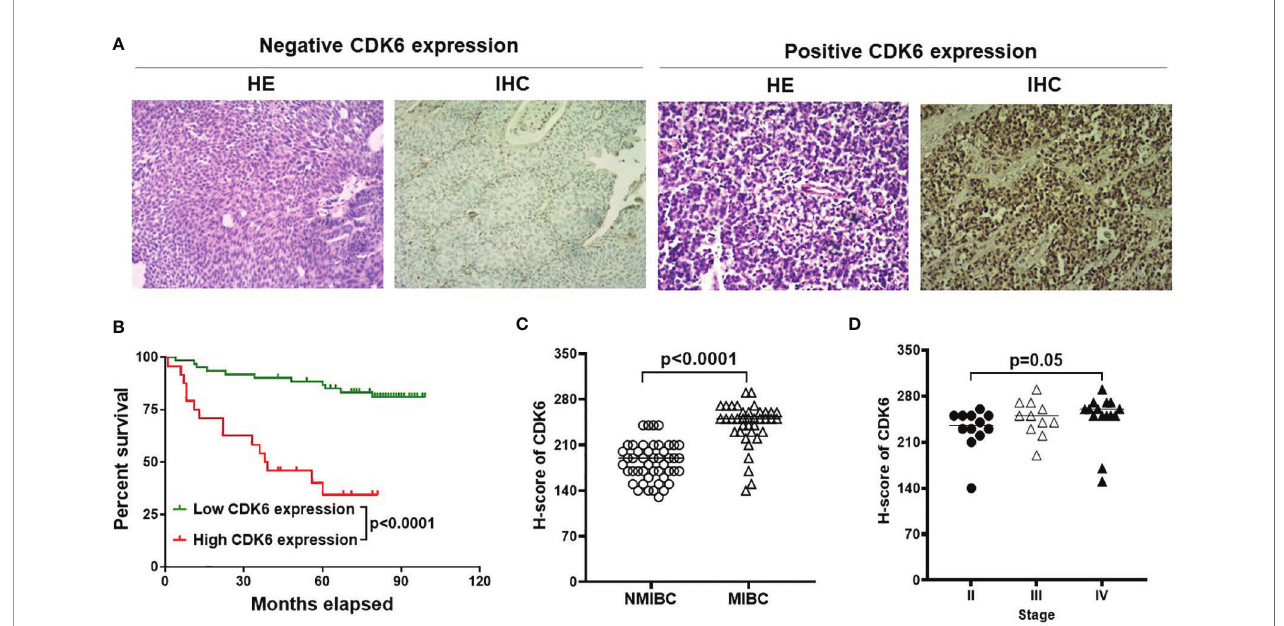
FIGURE 2 | IHC for CDK6 expression in BLCA. Representative images of H&E and IHC staining from negative and diffusely strong positive cases [ (A) , Magni fi cation, X40]. Cases with high H-score was correlated with worse prognosis compared with low or no expression group [ p < 0.0001, (B) ]. Furthermore, MIBC group (n=38) displayed higher CDK6 expression compared to NMIBC group (n=47) [ p < 0.0001, (C) ], but there was no difference among advanced stages [from stage II to IV, p = 0.05, (D)